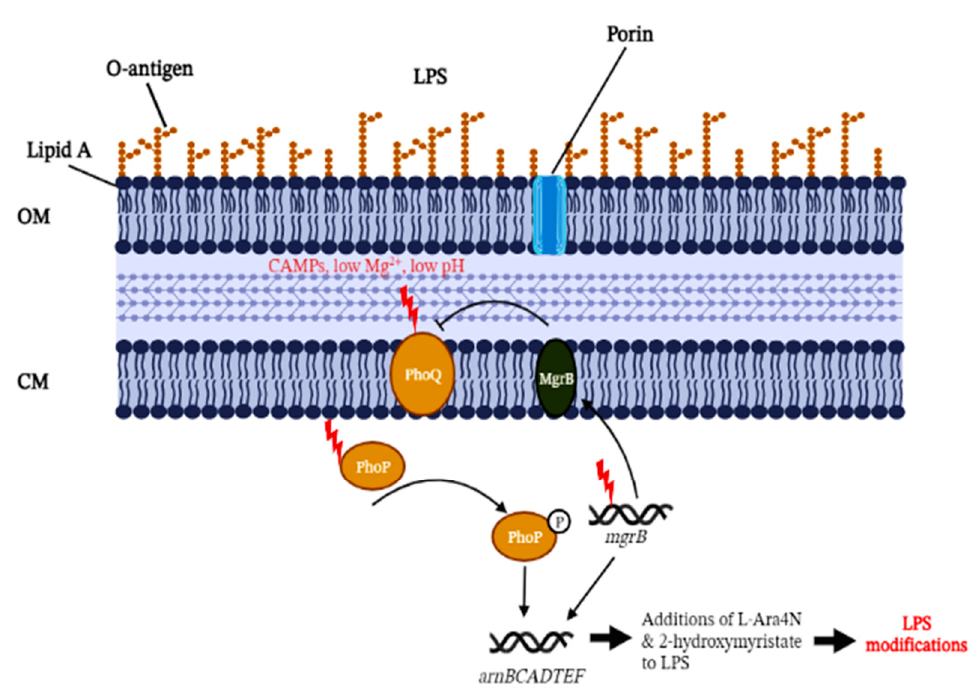
Figure 1. Summarised colistin resistance mechanism associated with MgrB inactivation in Klebsiella pneumoniae. PhoQ is stimulated by low extracellular cationic magnesium or cationic antimicrobial peptides (CAMPs) under low pH conditions, leading to increased PhoP phosphorylation. This, in turn, drives the transcription of mgrB. The accumulation of MgrB results in a negative feedback loop to inhibit the kinase activity of PhoQ, which subsequently suppresses PhoP phosphorylation. Mutations (denoted by red-coloured thunder symbols) in mgrB or MgrB inactivation disrupting the PhoP/PhoQ pathway eliminates this partial adaptation. The disruption of mgrB can mediate the activation of the arnBCADTEF operon for the addition of L-Ara4N to lipid A. Phosphorylated PhoP can also directly activate the arnBCADTEF operon without other PmrA/PmrB-activated proteins in K. pneumoniae. OM, outer membrane; CM, cytoplasmic membrane, LPS, lipopolysaccharide, L-Ara4N, 4-amino-4-deoxy- L -arabinose. (Created with BioRender.com, accessed on 16 August 2022).